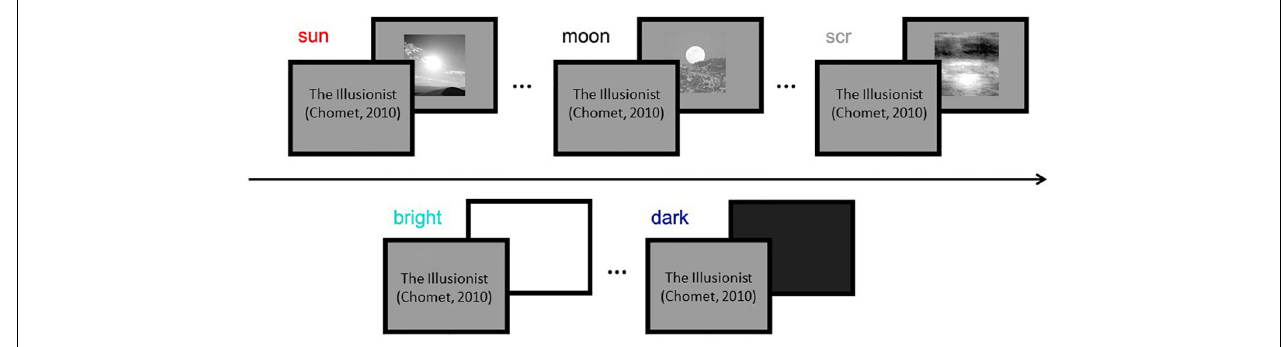
FIGURE 1 | Schematics of the experimental stimuli and procedure. Top: images (sun, moon, and meaningless control images) were presented for 1s each in random order, embedded within an animation movie (Chomet, 2010; for copyright reasons the frames of the cartoon are replaced by title and author of the movie in this Figure). Note: all tested stimuli were achromatic; the movie (in color) merely filled the inter-stimulus intervals and was common to all conditions. Bottom: the same protocol was used for the presentation of full-screen maximum or minimum luminance squares, for testing the pupillary light or dark response.